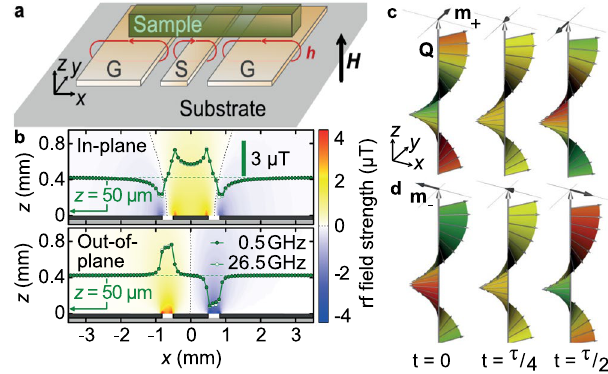
Figure 1. Coplanar waveguide field distribution and spin precessional motion in the magnetic helix. ( a ) Sketch of a bar-shaped sample on top of a CPW. ( b ) Color-coded field components h x (top) and h z (bottom) modelled by finite-element electromagnetic simulations 47 for a CPW with a 1 mm wide signal line. Green data points illustrate h x ( x ) and h z ( x ) at a height of z = 50 μ m exhibiting both a maximum strength of about 3 μ T. A power of 1 mW and an impedance of 50Ω were considered. ( c , d ) Illustrations of precessional motion of spins (thin gray arrows) and averaged dynamic magnetization m σ ( x , y , t ) with σ = + , − (dark arrows) for selected times t during a period τ of modes ( c ) + Q and ( d ) − Q. Colors indicate the phase evolution along the helical propagation vector Q . Red (green) color highlights smaller (larger) misalignment angle between neighboring spins compared to their equilibrium position (yellow). We modelled our sample with N x < N y at H = 0, inducing the extraordinary linear polarization of m (Supplementary Videos